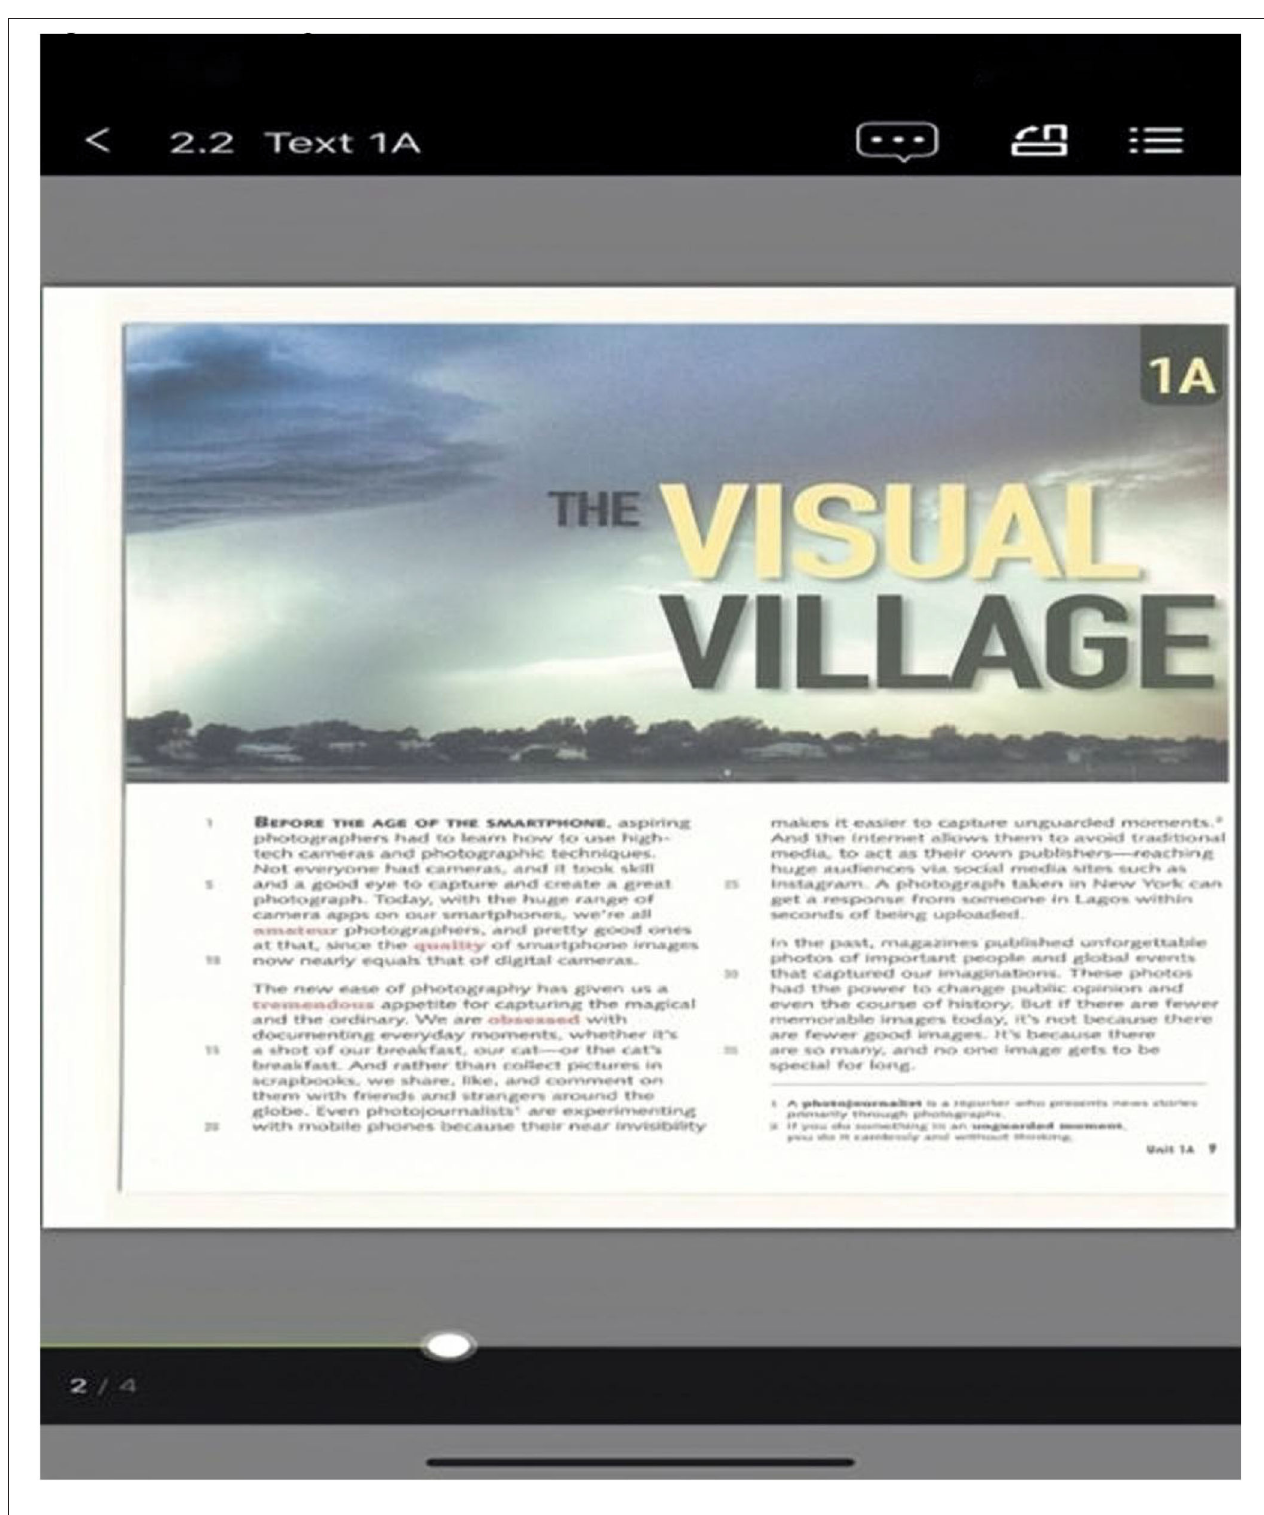
FIGURE 1 | Icourse—Text preview